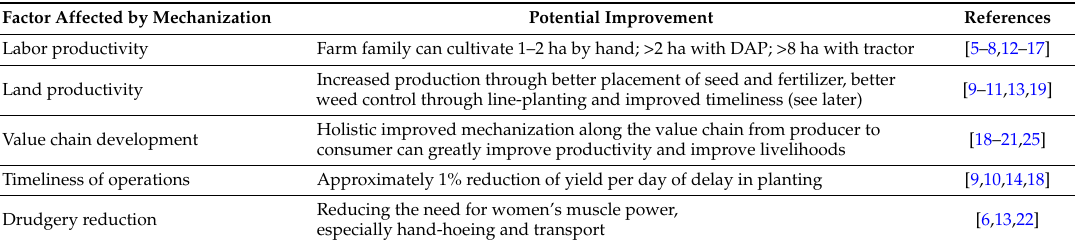
Table 2. Examples of the positive impacts of mechanization on smallholder livelihoods.